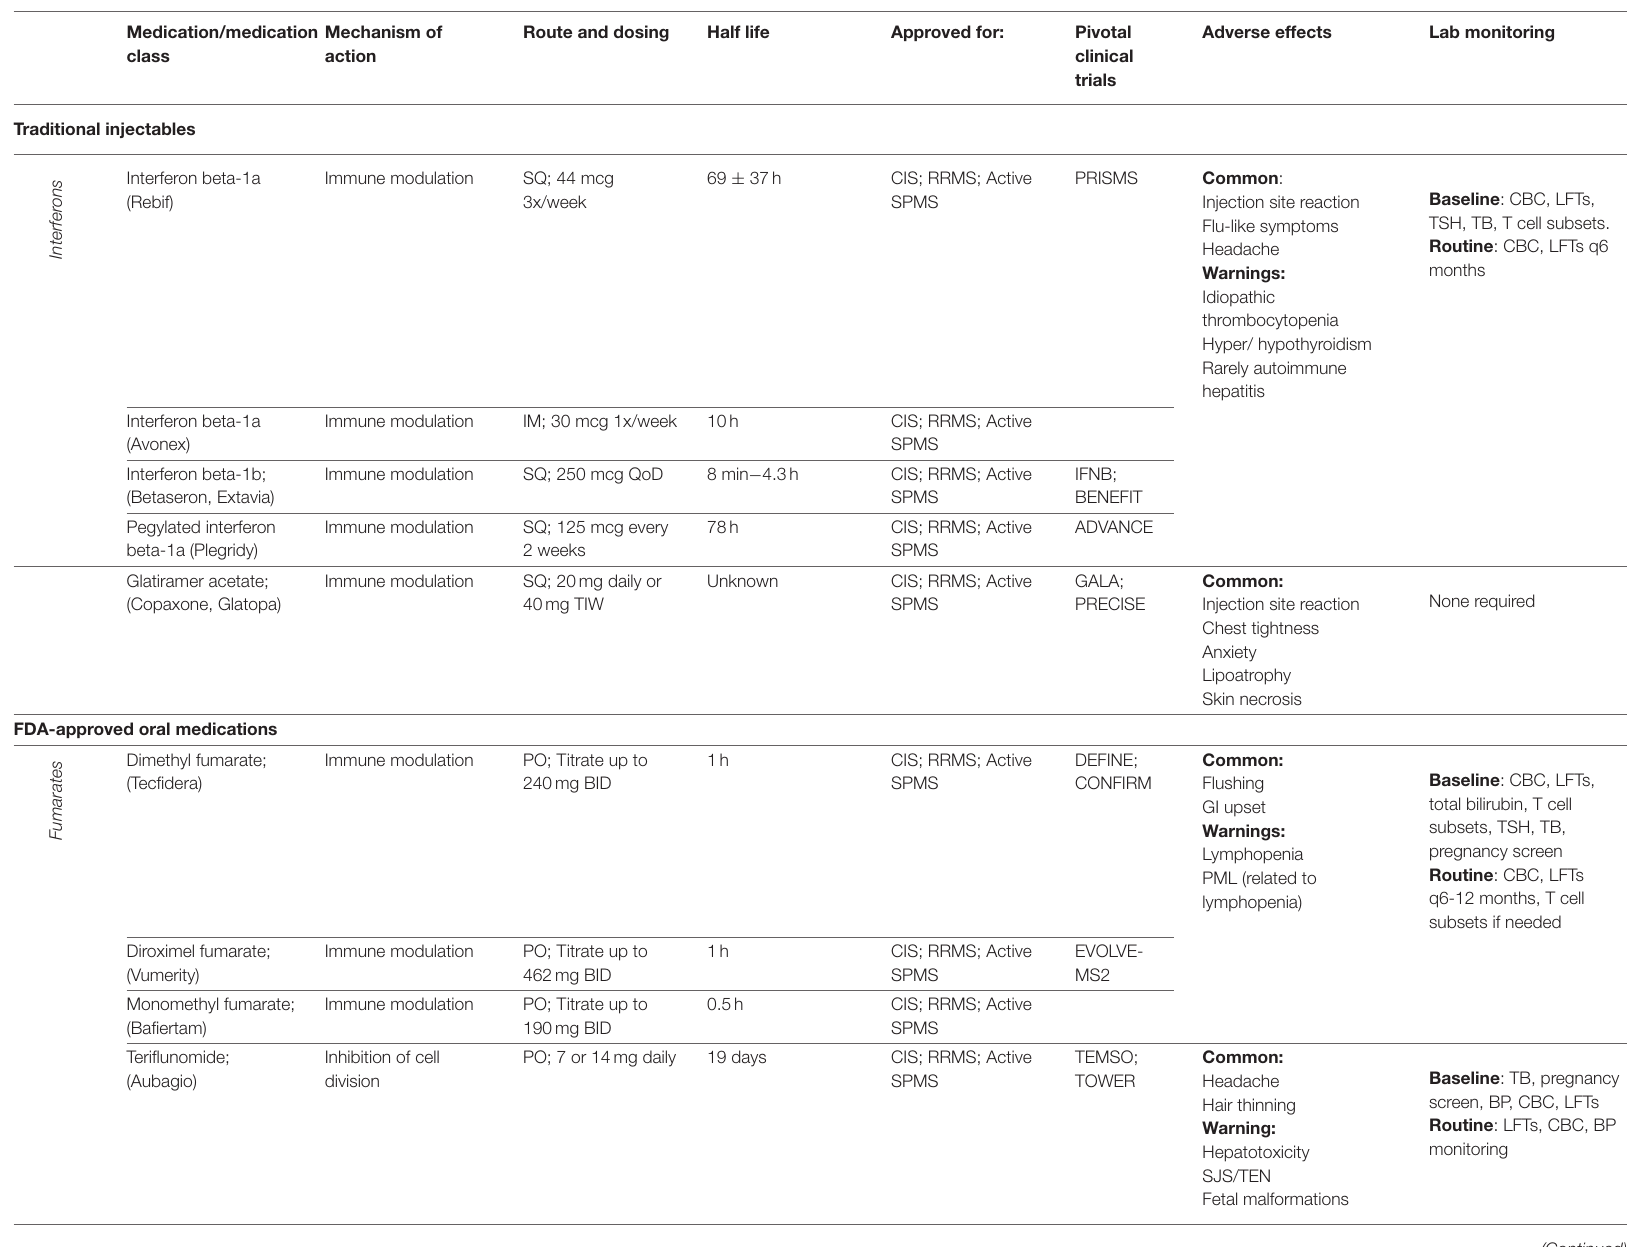
TABLE 1 | Current therapeutic treatments for